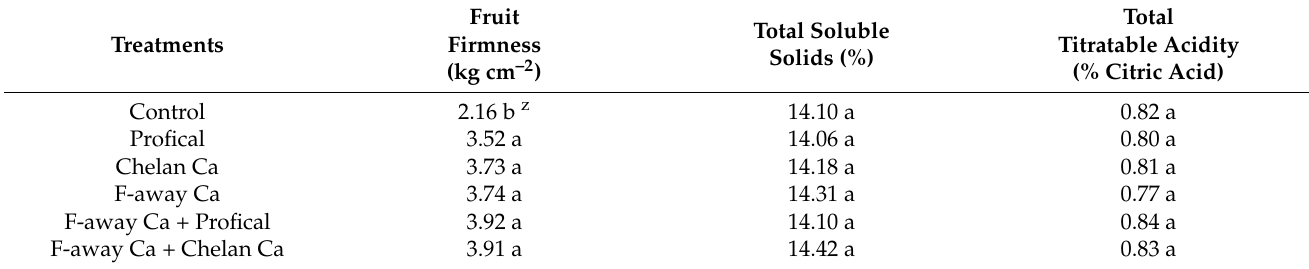
Table 5. Fruit firmness, total soluble solids and total titratable acidity after four months of cold storage (means of 2 years).